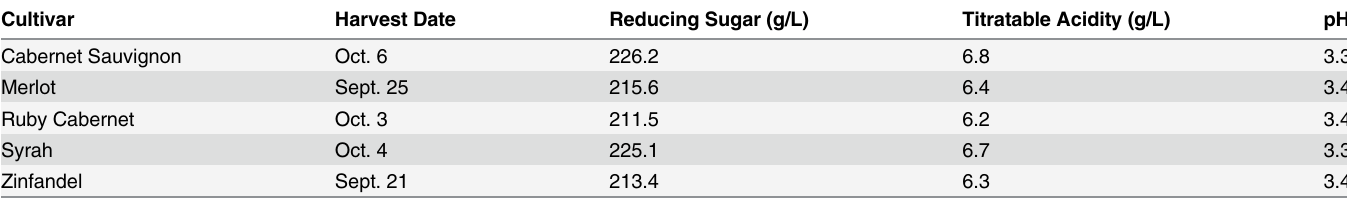
Table 1. Grape cultivars and fruit composition at